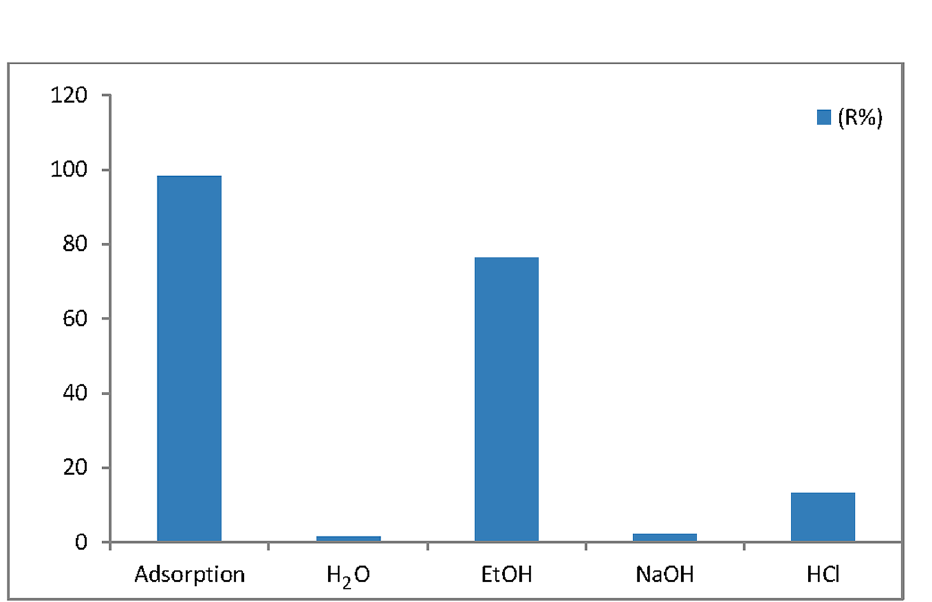
Figure 12. Desorption of MB onto Cu (OH) 2